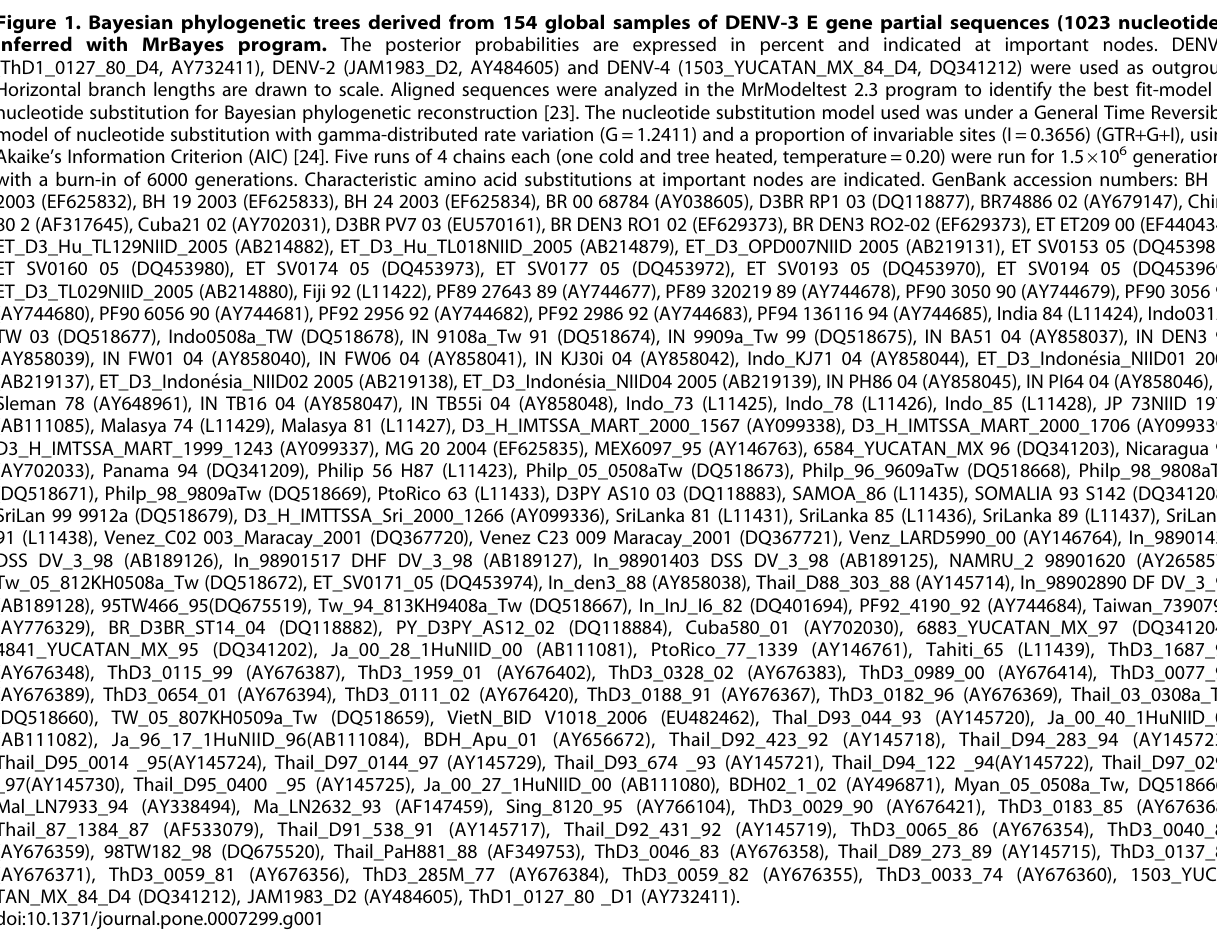
Figure 1. Bayesian phylogenetic trees derived from 154 global samples of DENV-3 E gene partial sequences (1023 nucleotides) inferred with MrBayes program. The posterior probabilities are expressed in percent and indicated at important nodes. DENV-1 (ThD1_0127_80_D4, AY732411), DENV-2 (JAM1983_D2, AY484605) and DENV-4 (1503_YUCATAN_MX_84_D4, DQ341212) were used as outgroup. Horizontal branch lengths are drawn to scale. Aligned sequences were analyzed in the MrModeltest 2.3 program to identify the best fit-model of nucleotide substitution for Bayesian phylogenetic reconstruction [23]. The nucleotide substitution model used was under a General Time Reversible model of nucleotide substitution with gamma-distributed rate variation (G=1.2411) and a proportion of invariable sites (I=0.3656) (GTR + G + I), using Akaike’s Information Criterion (AIC) [24]. Five runs of 4 chains each (one cold and tree heated, temperature=0.20) were run for 1.5 6 10 6 generations, with a burn-in of 6000 generations. Characteristic amino acid substitutions at important nodes are indicated. GenBank accession numbers: BH